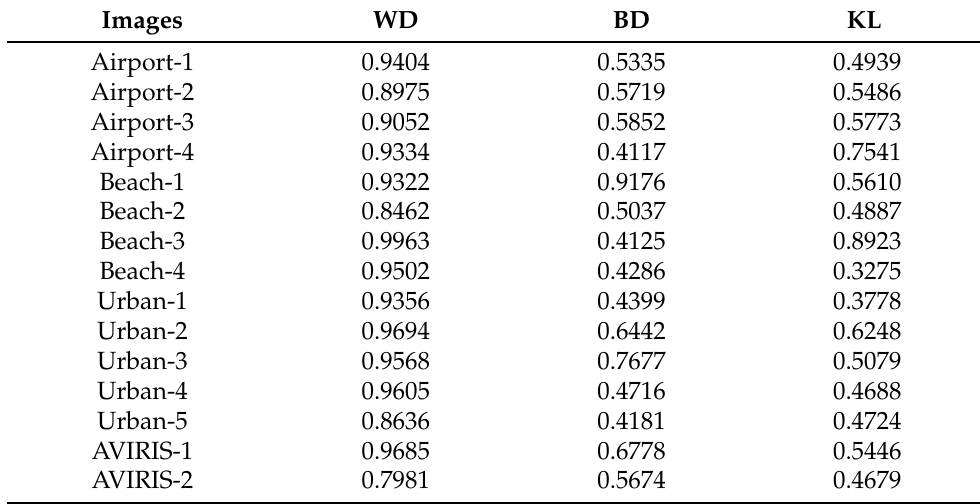
Table 4. Comparison of AUC scores achieved by different